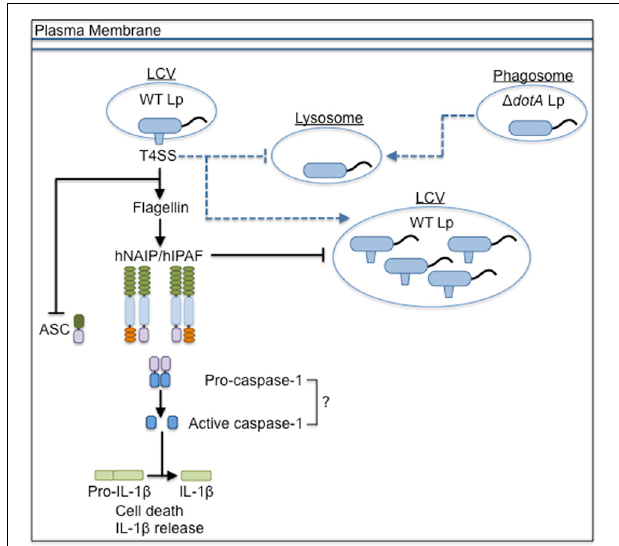
FIGURE 2 | The inflammasome-mediated response to L. pneumophila in human cells. L. pneumophila that do not express a functional T4SS ( (cid:2) dotA Lp) traffic to the lysosome, but wild-type L. pneumophila (WT Lp) use the T4SS to translocate effectors into the host cytosol to establish a replicative niche, the Legionella -containing vacuole (LCV), and block fusion with lysosomes. The presence of flagellin triggers signaling through hNAIP/hIPAF that blocks replication of WT Lp, though it is unclear if caspase-1 is involved in restriction. T4SS activity down-regulates the expression of ASC. Dashed lines represent vesicular trafficking patterns. Solid lines represent pathways for activation of the host response. Arrows at the end of lines represent induction, while flat bars at the end of lines represent